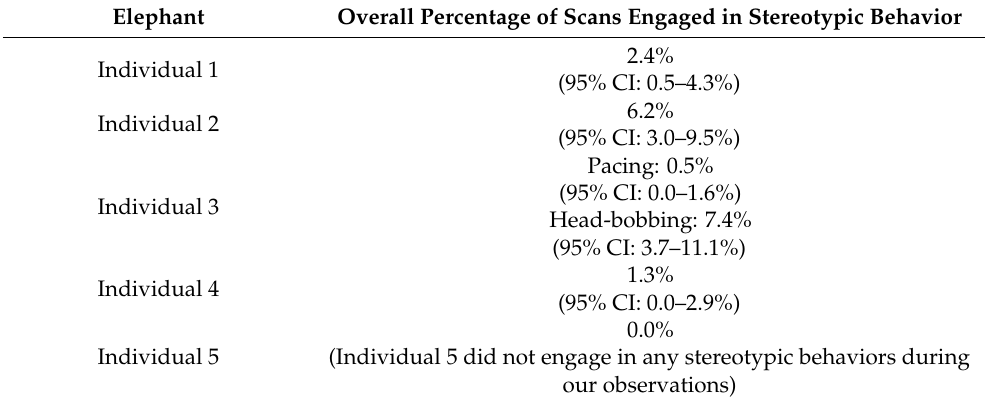
Table 5. Percentage of Total Scans Engaged in Stereotypic Behavior for Each Focal Animal.